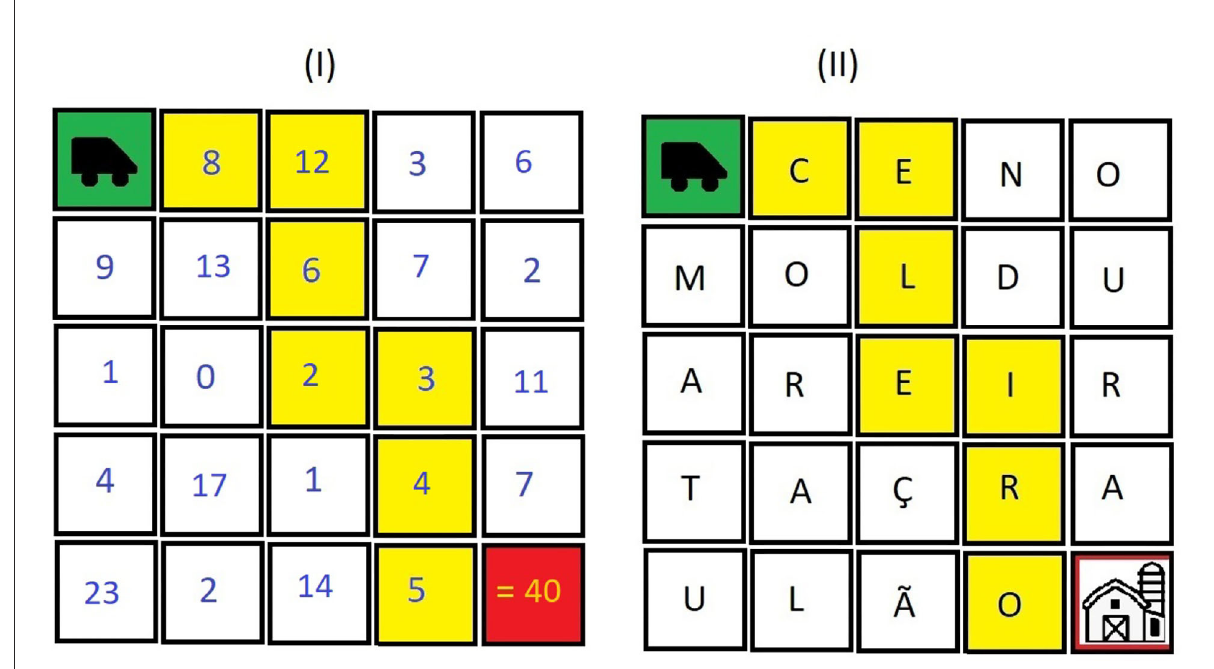
FIGURE6 In (I) , all path numbers sum up to 40, and in (II) , concatenated letters form the Portuguese word “celeiro,” i.e., barn.